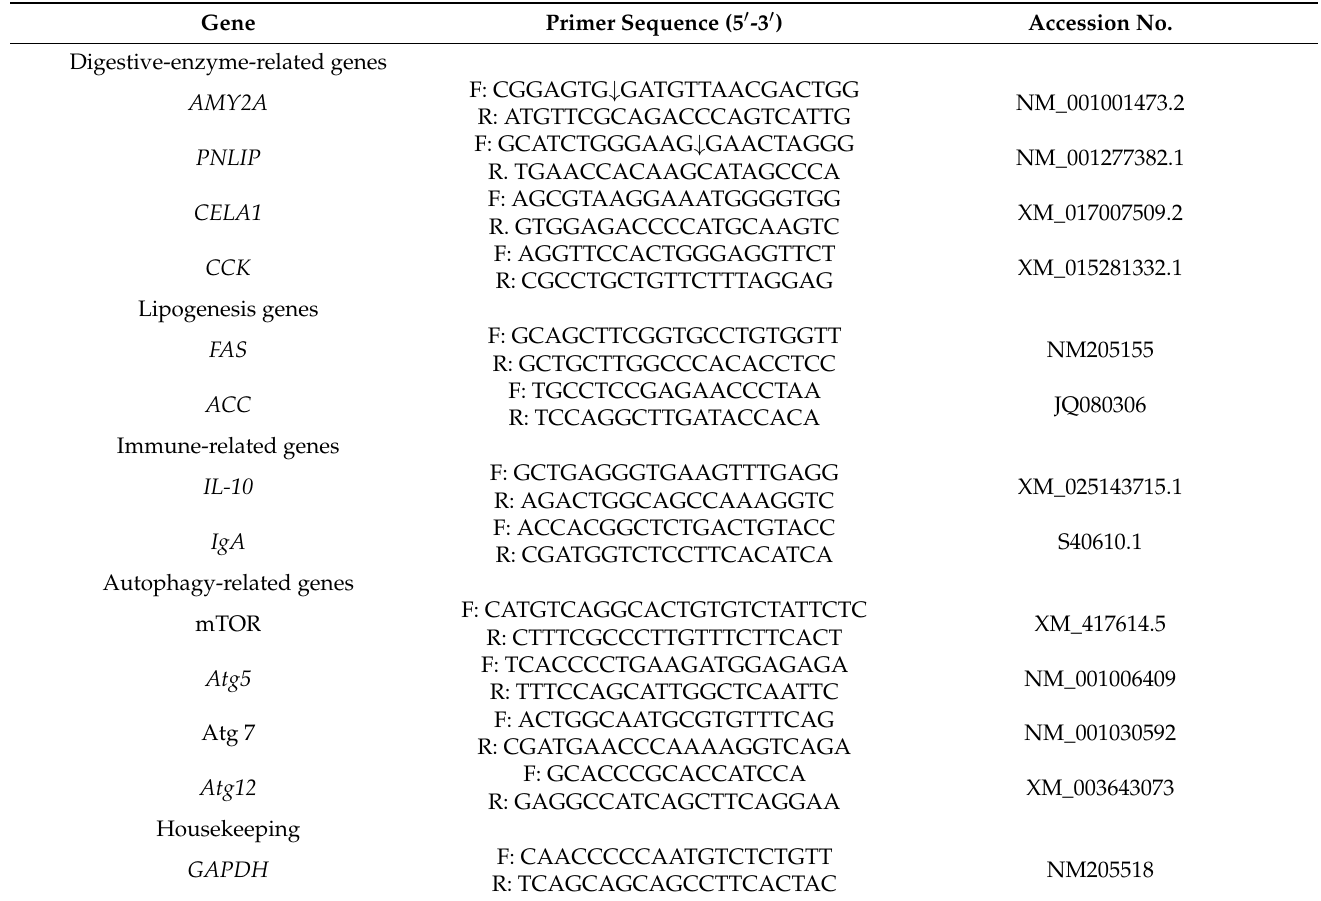
Table 2. Primer sequences used for gene expression analysis by RT–qPCR